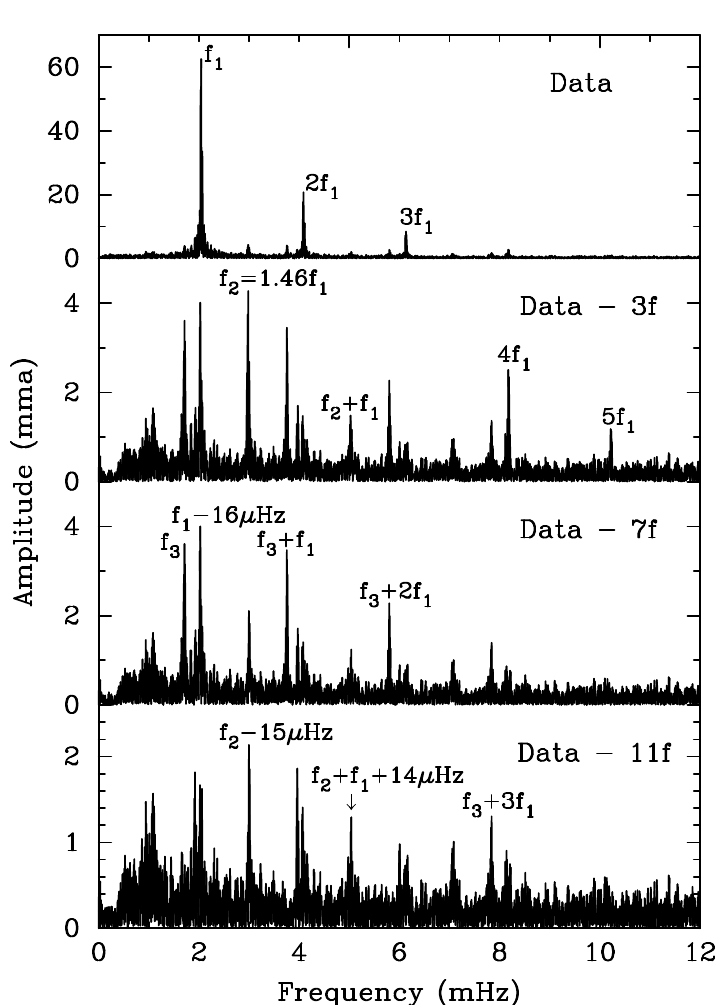
Fig. 3. Fourier amplitude spectra of the INT measurements of PG